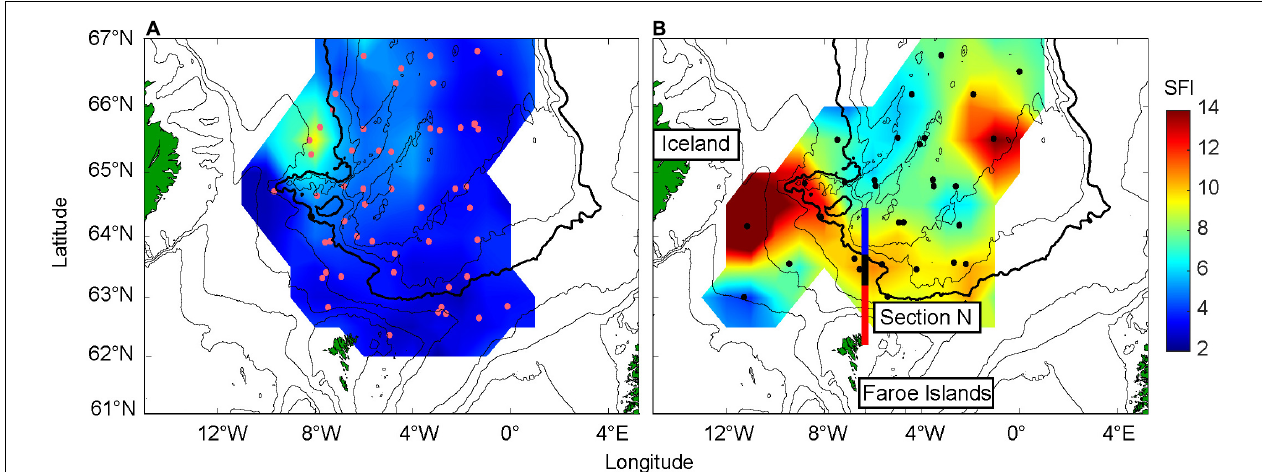
Figure 1 . The purple (A) and black (B) dots show the positions where stomach samples were collected. The 200, 500, 1,000, 2,000 (bold), 2,500, and 3,000 m depth contours are